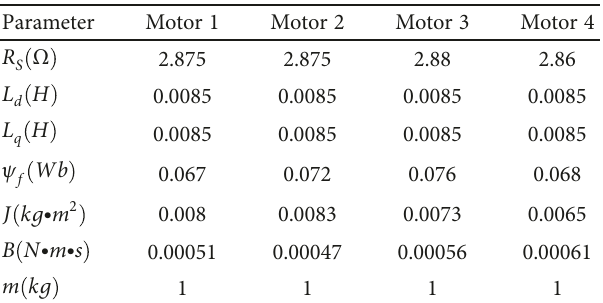
Table 2: Parameters of four